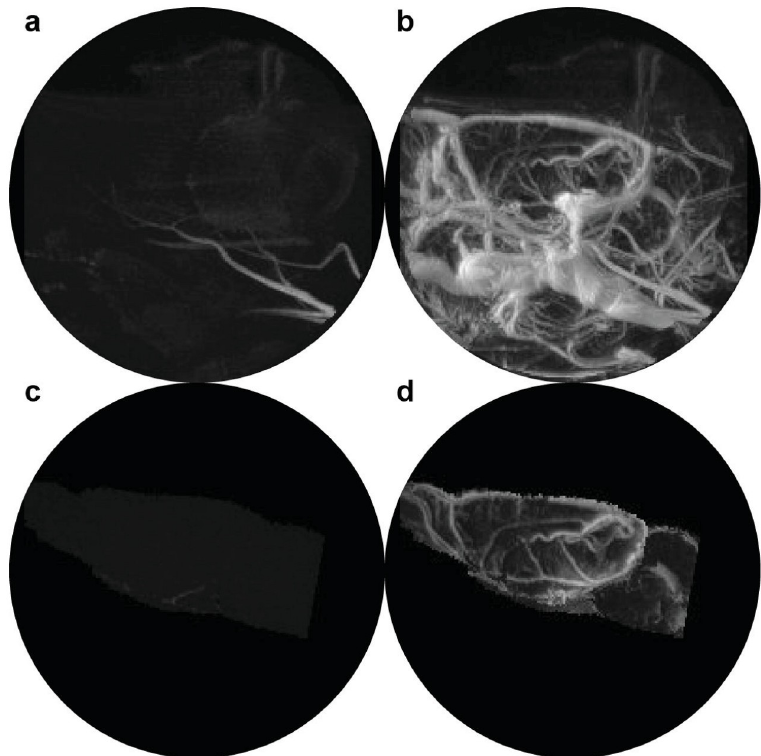
Fig 1. QUTE-CE MRI angiograms. Maximum intensity projection images (MIPs) of the whole rat head at 8 months are displayed (a) pre-contrast and (b) post-contrast 14mg/kg ferumoxytol. Unique contrast-enhanced vascular MIPs are obtained, and segmentation of the brain from the pre- and post-contrast images (c and d, respectively) demonstrates that time-of-flight signal enhancement is limited to the arteries at the periphery of the field of view and so the signal does not contribute to biomarker